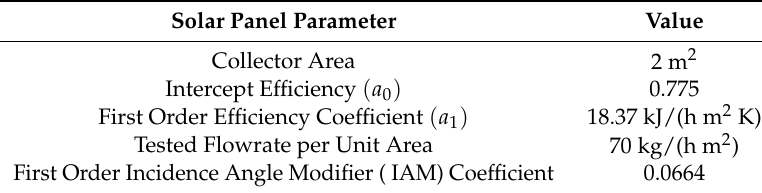
Table 7. Solar Panel Parameters for Solar Rating and Certification Corporation (SRCC) Data Sheet.